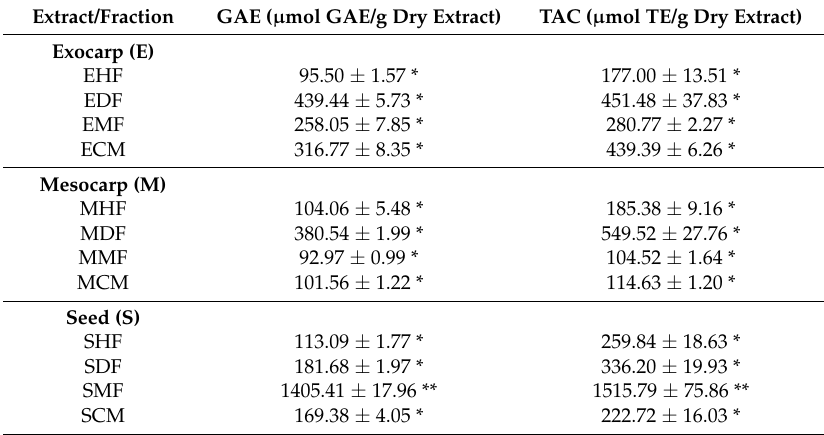
Table 1. Gallic acid equivalence (GAE) and total antioxidant capacity (TAC) of crude extracts and fractions of D. indum